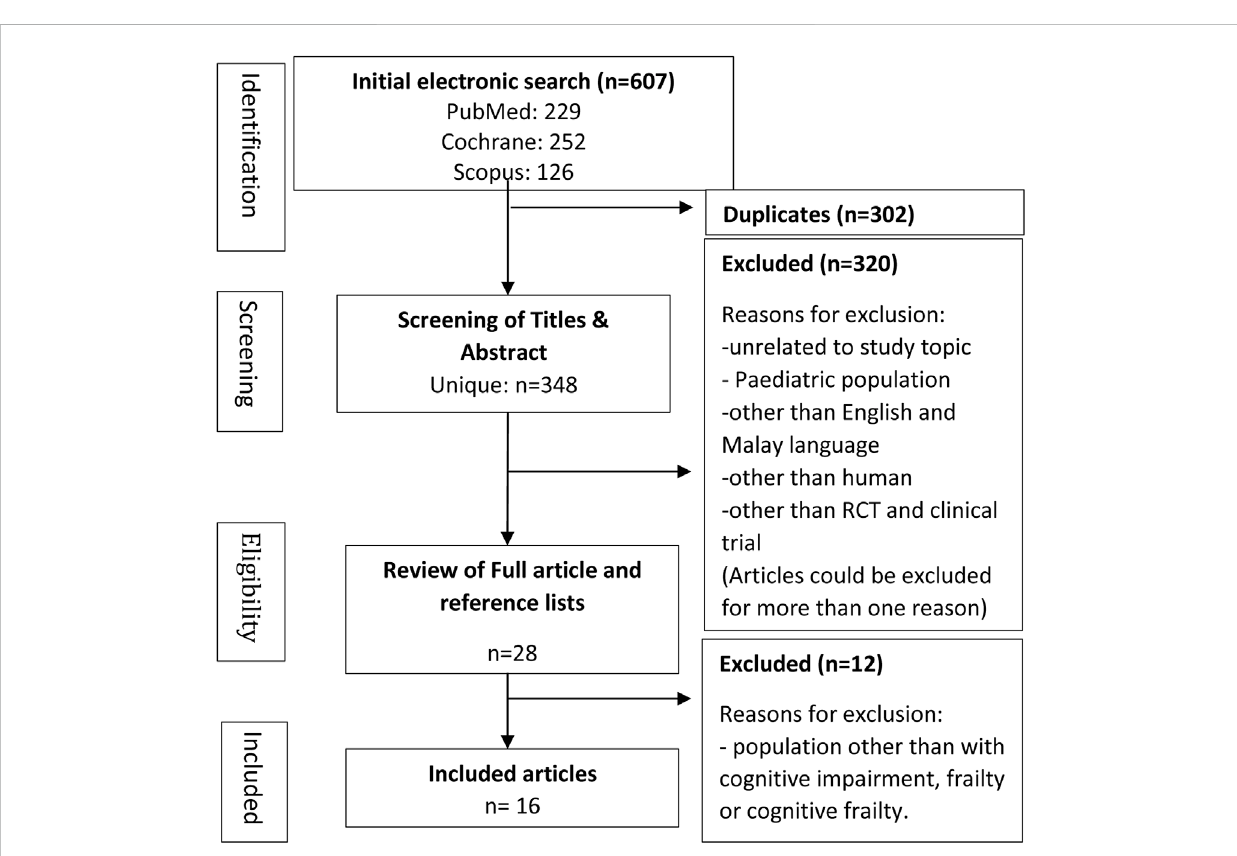
FIGURE 1 Syntax of literature search and selection process. PRISMA fl ow diagram: cardiovascular-health biomarkers in intervening older adults with cognitive